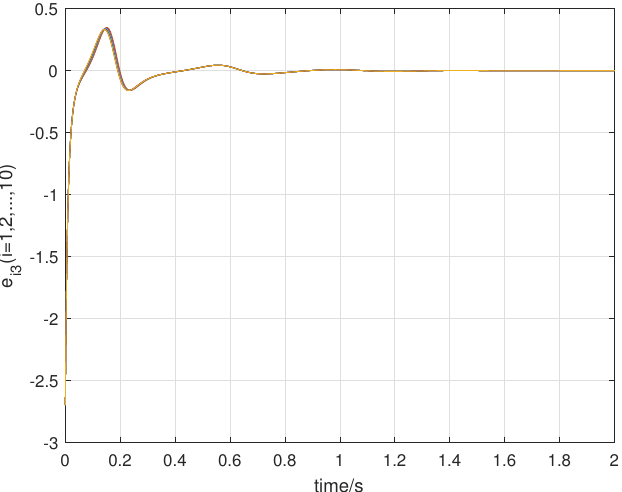
Figure 8. Trajectories of synchronization errors e j 3 ( 1 ≤ j ≤ 10 ) for the complex networks (77) and (80) with 10 fractional order nodes with time variance.